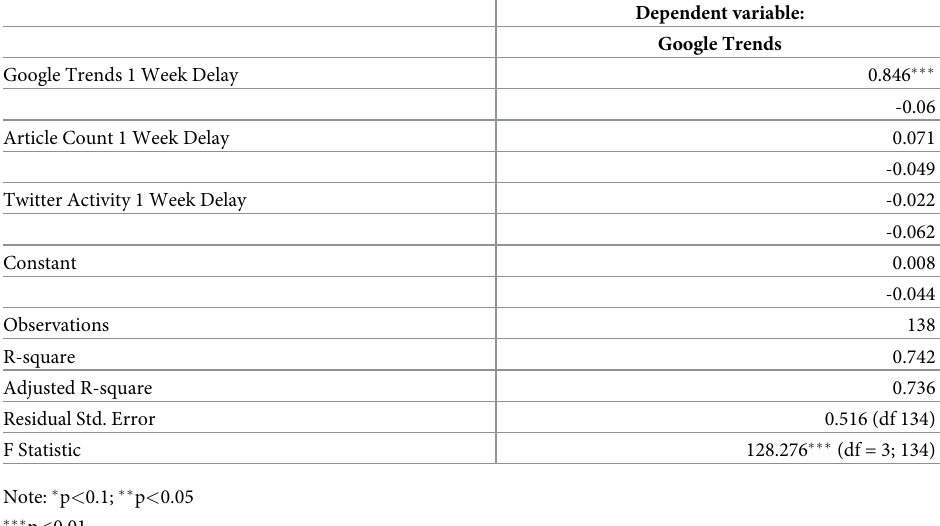
Table 2. Temporal effect of Google search behavior on Twitter and newspaper coverage.